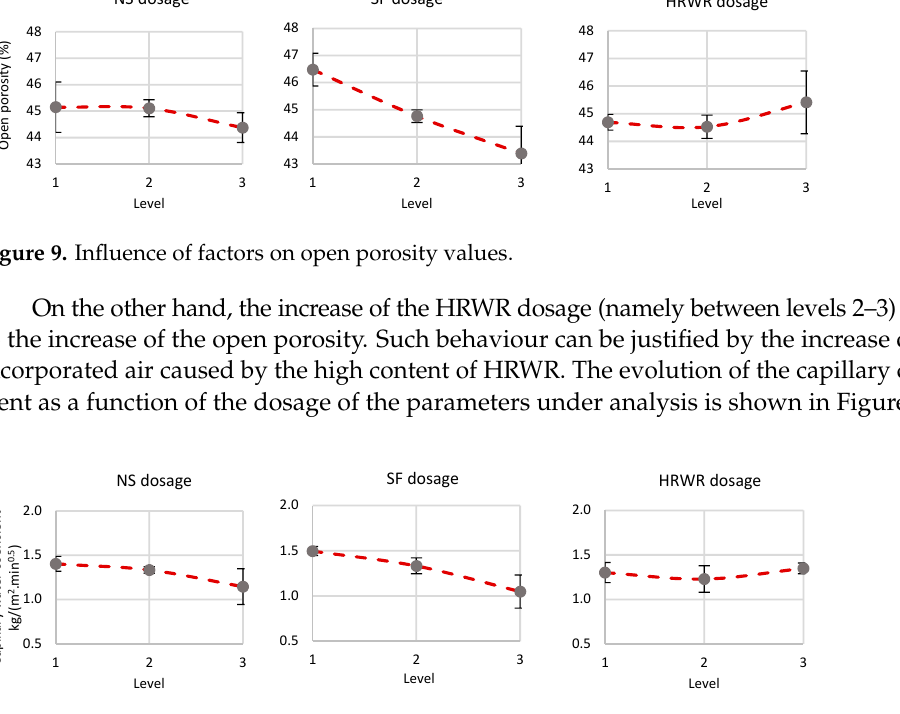
Figure 10. Influence of factors on water absorption coefficient by capillarity values.